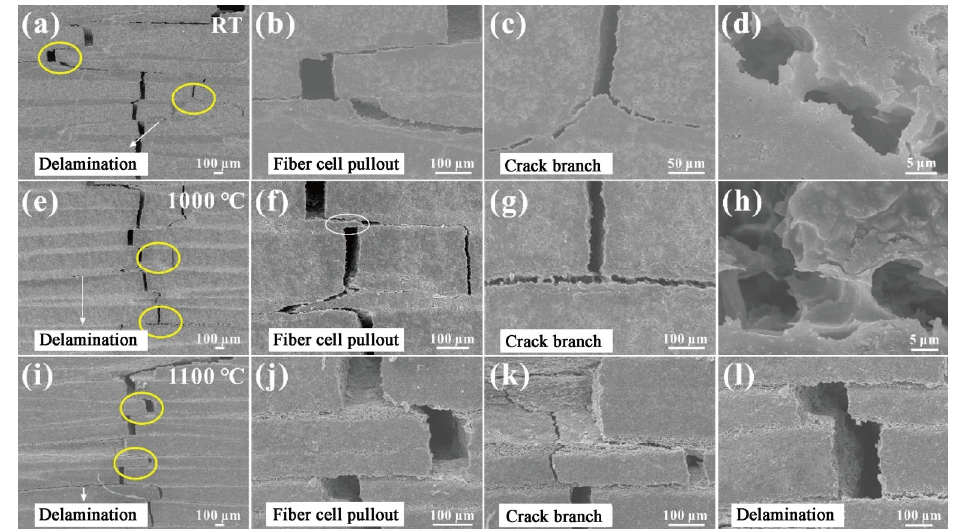
Fig. 7 Crack propagation paths of PcBN/hBN fibrous monolithic ceramics at different test temperatures: (a–d) RT; (e–h) 1000 ℃ ; and (i–l) 1100 ℃ .